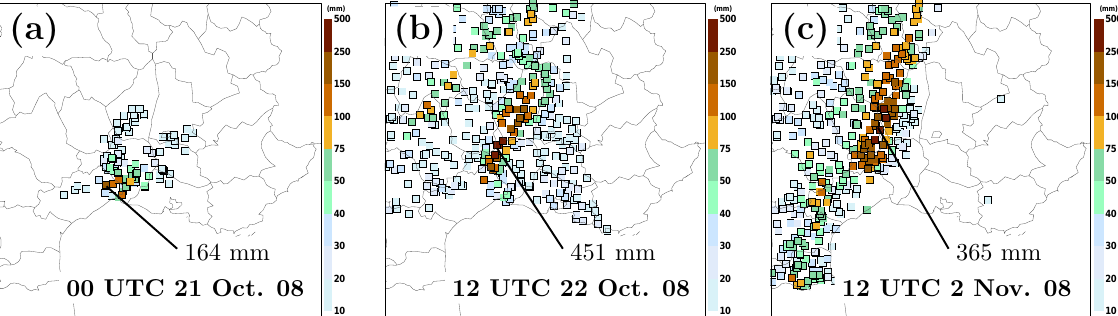
Fig. 2. Observed 24-h accumulated precipitation (mm) at (a) 00:00 UTC 21 October 2008, (b) 12:00 UTC 22 October 2008 and (c) 12:00 UTC 2 November 2008.